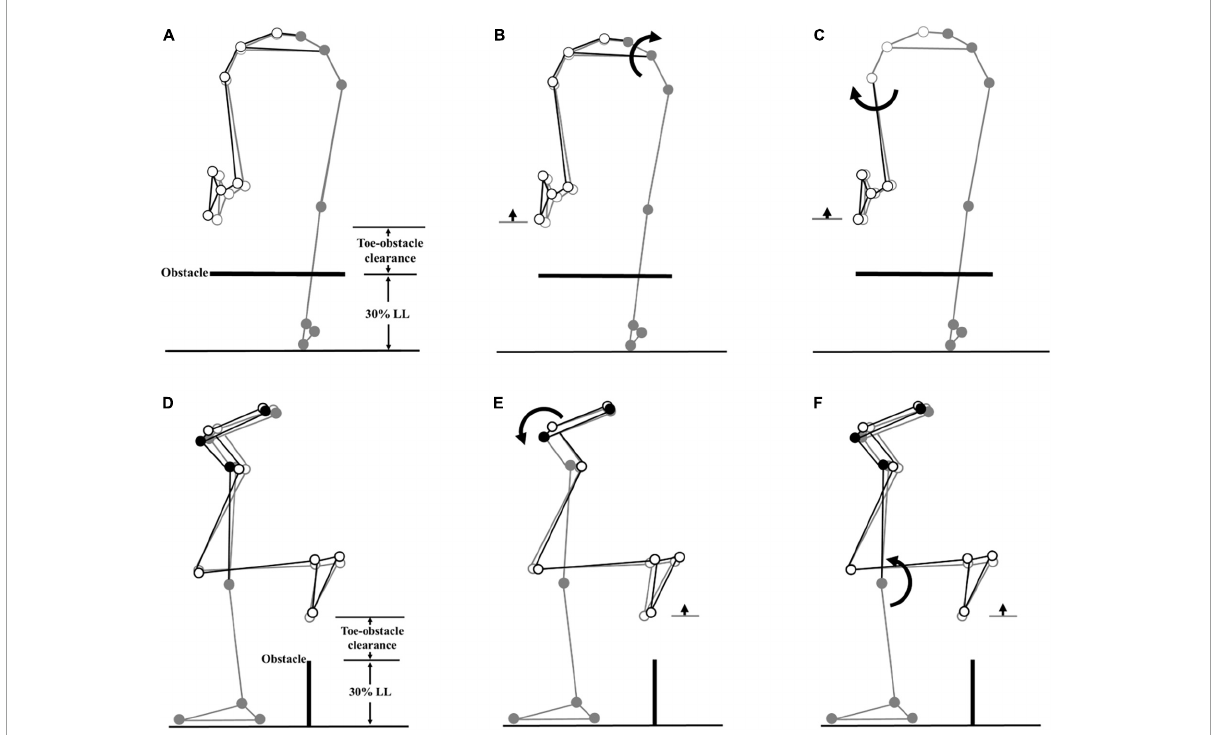
FIGURE5 Effects of the observed significant angular changes at individual joints on the trailing toe-obstacle clearance in the TCC group (black stick figure) compared with the non-TCC controls (gray stick figure) when the trailing toe was above an obstacle of 30% LL in height. The stick model was drawn using each group’s marker positions of a typical subject, the segments with solid gray circles being joints of the reference limb. With the stance foot fixed to the ground, only one joint was rotated at a time according to the mean angular change reported in Tables 3 , 5 , while keeping the angles of the other joints fixed, and the segments of the stance limb and the segments of the swing limb distal to the current joint stationary. In the frontal plane, the observed increase of toe-obstacle clearance in the TCC group (A) was associated with significantly increased pelvic hiking (B) and decreased swing hip adduction (C) , while in the sagittal plane, the observed increase of toe-obstacle clearance (D) was associated with the significantly increased pelvic anterior tilt (E) and decreased stance knee flexion (F)